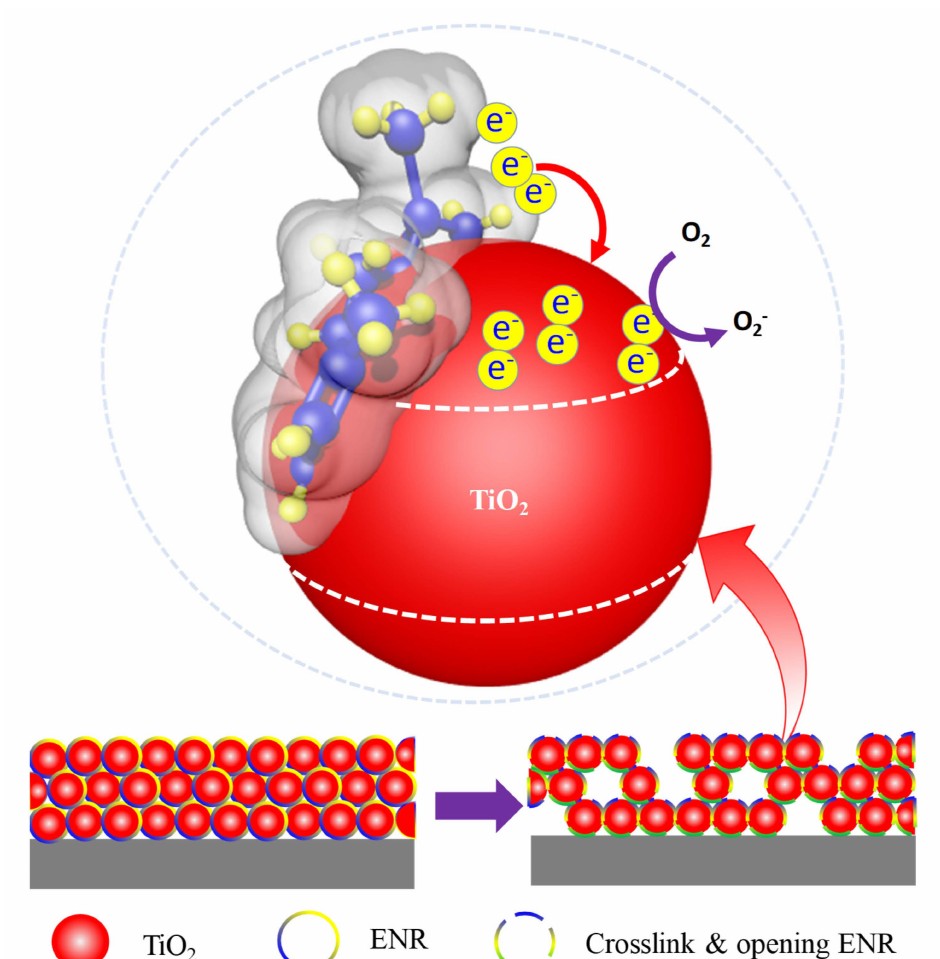
Figure 14. Diagram of immobilized TiO 2 surface before and after the photoetching